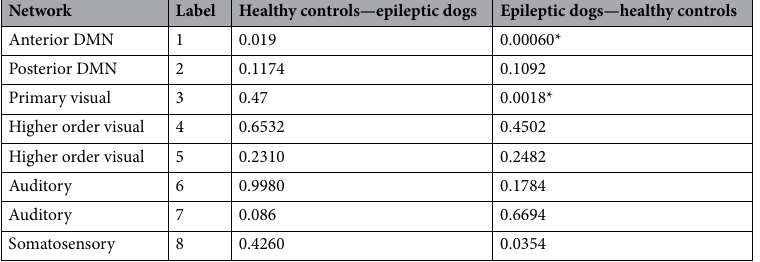
Network Label Healthy controls—epileptic dogs Epileptic dogs—healthy